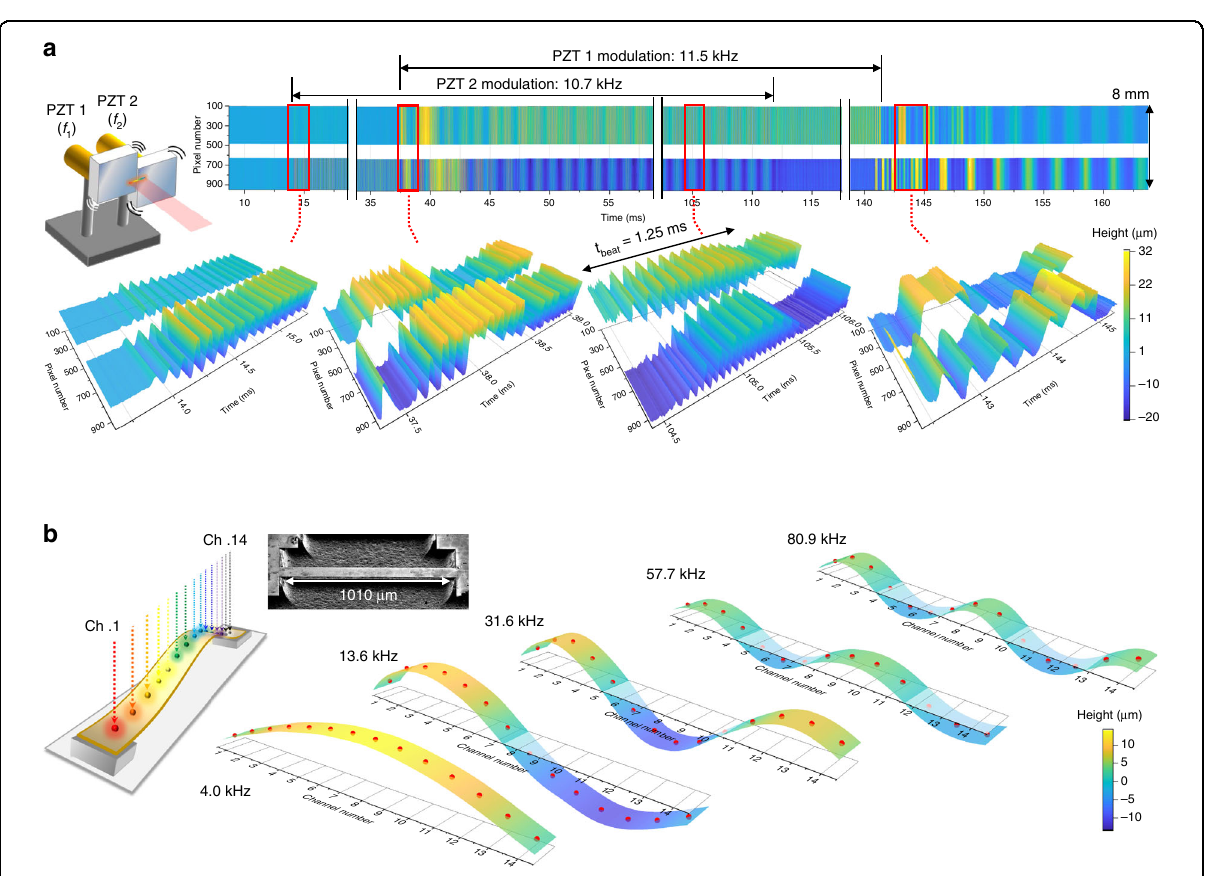
Fig. 4 Dynamic imaging results. a Interaction between two PZT-attached mirrors. f = 75 mm lens is used for ~10 mm horizontal FOV. The two PZTs are driven for ~100 ms durations with ~25 ms delay. The lower panels illustrate reconstructed TOF traces at the moment of modulation start, interaction transient, steady-state, and end of modulation in sequence. The entire TOF trace record can be found in Supplementary Video 1. b Real- time observation on MEMS bridge ’ s fl exural mode shapes. 14 beams with ~8 μ m beam size and ~880 μ m FOV are incident along the length of the bridge (see Methods). The resonant motions of fi rst fi ve fl exural modes (from 4.0 to 80.9 kHz) are measured. TOFs of 14 local positions are indicated by red dots and TOF pro fi le between dots is interpolated with the spline method. Inset photo shows the scanning electron microscope image. The entire TOF trace record can be found in Supplementary Video